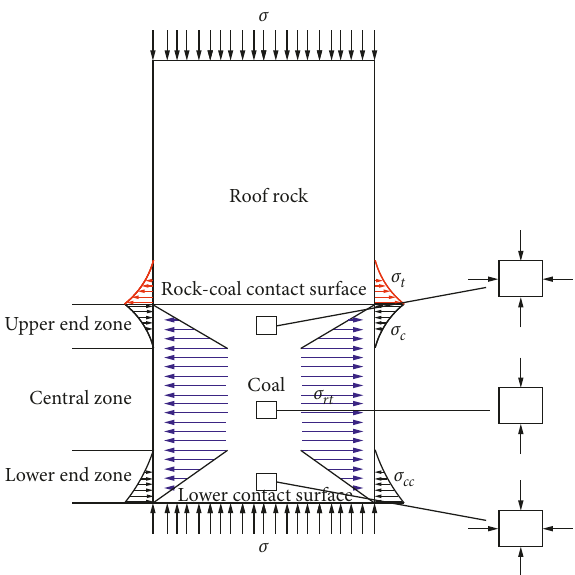
Figure 4: Stress state of the coal in the composite